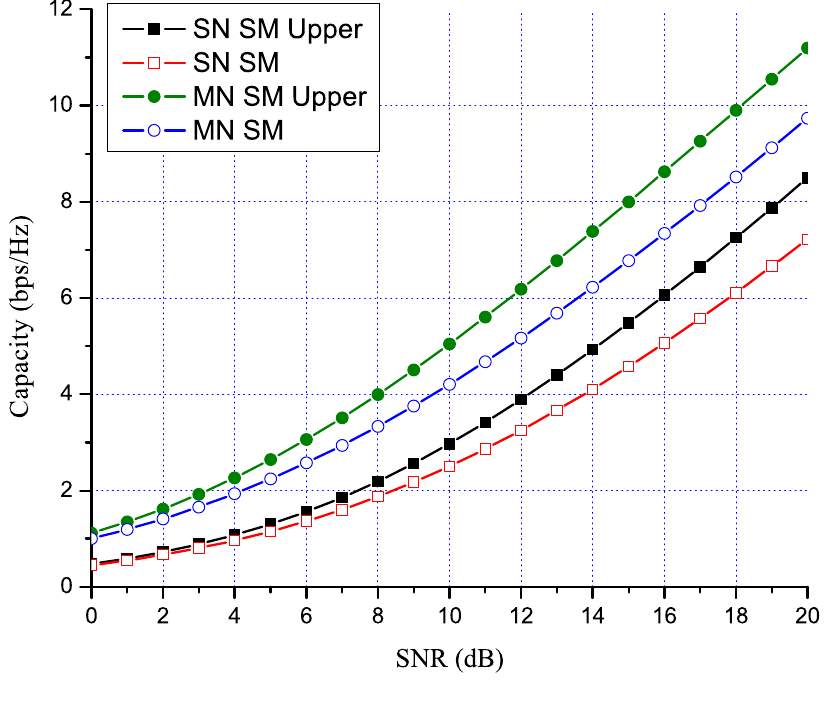
Figure 3. SM 2 × 2 MIMO capacity ( η = 0 . 2 and µ = 0 . 4